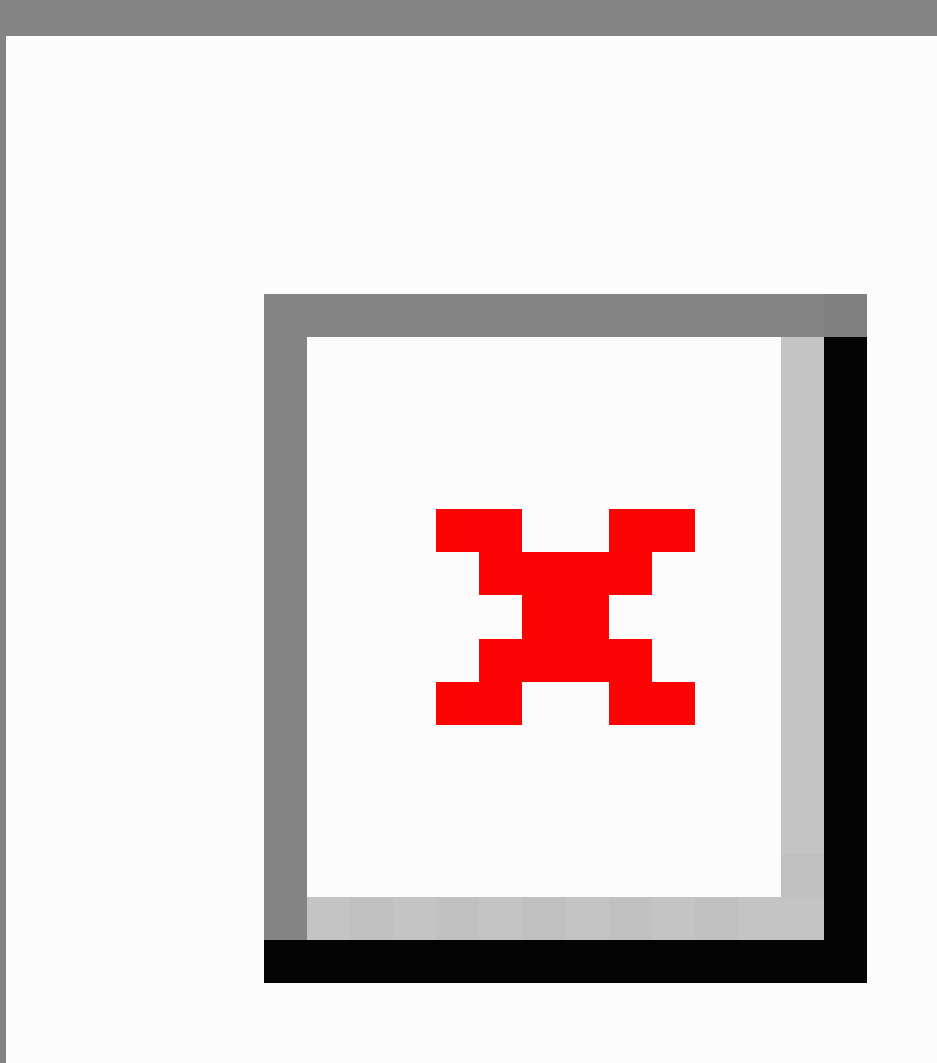
Figure 2. Screenshot of Head Matters. Exercise 1: Move your shoulders up and